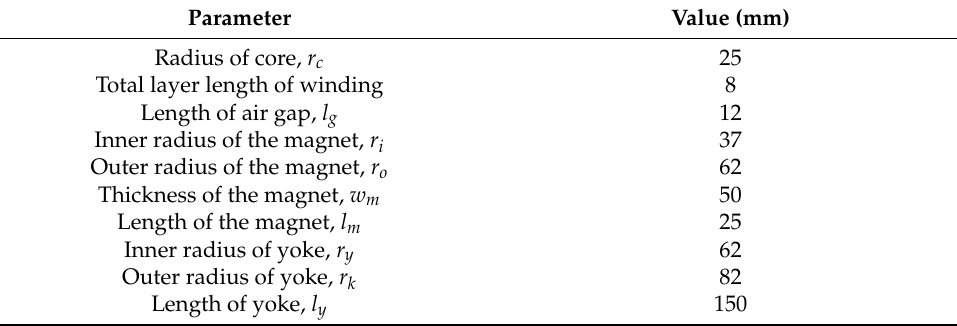
Figure 3. Cross sectional view of the CDCLM. ( a ) vertical section; ( b ) horizontal section. Table 1. Values of the parameter of the CDCLM.